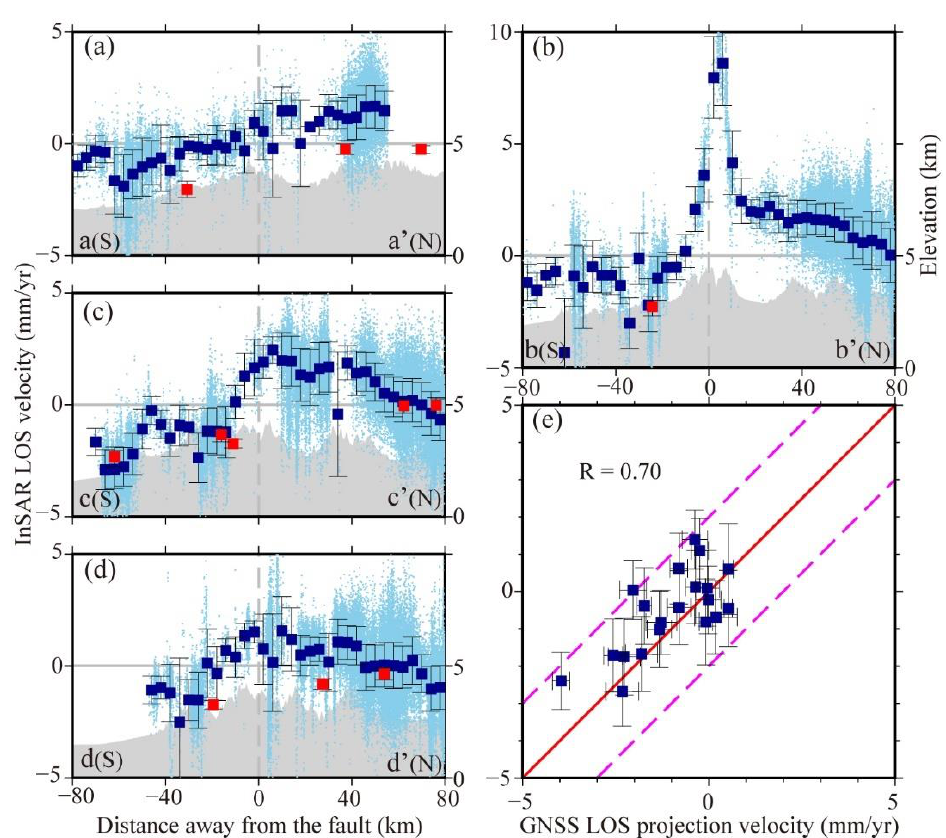
Figure 3. Comparison of InSAR and GNSS LOS-projected velocities. ( a – d ) The InSAR velocity profiles along aa’, bb’, cc’, and dd’ (see locations in Figure 2a). The light blue dots present the InSAR velocity (160 km long, 0.2 km wide). The dark blue squares are average values of the data within 4 km along the profiles; error bars are 1-sigma errors. The red squares present the GNSS LOS projection velocities; error bars are 1-sigma uncertainties (160 km long, 4 km wide). The light gray shadows represent the elevation along the profiles. ( e ) The InSAR values (y-axis) versus the GNSS values projected to LOS (x-axis). Red and cyan lines show the 1:1 relationship.